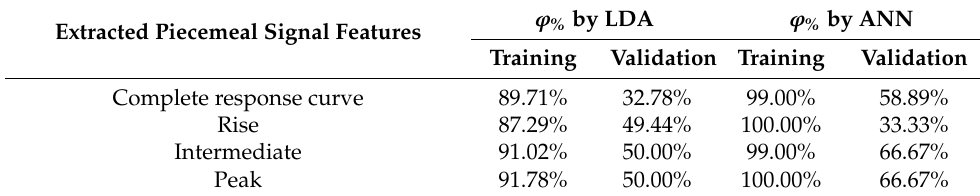
Table 12. Classification accuracy rates of all investigated conditions. Extracted Piecemeal Signal